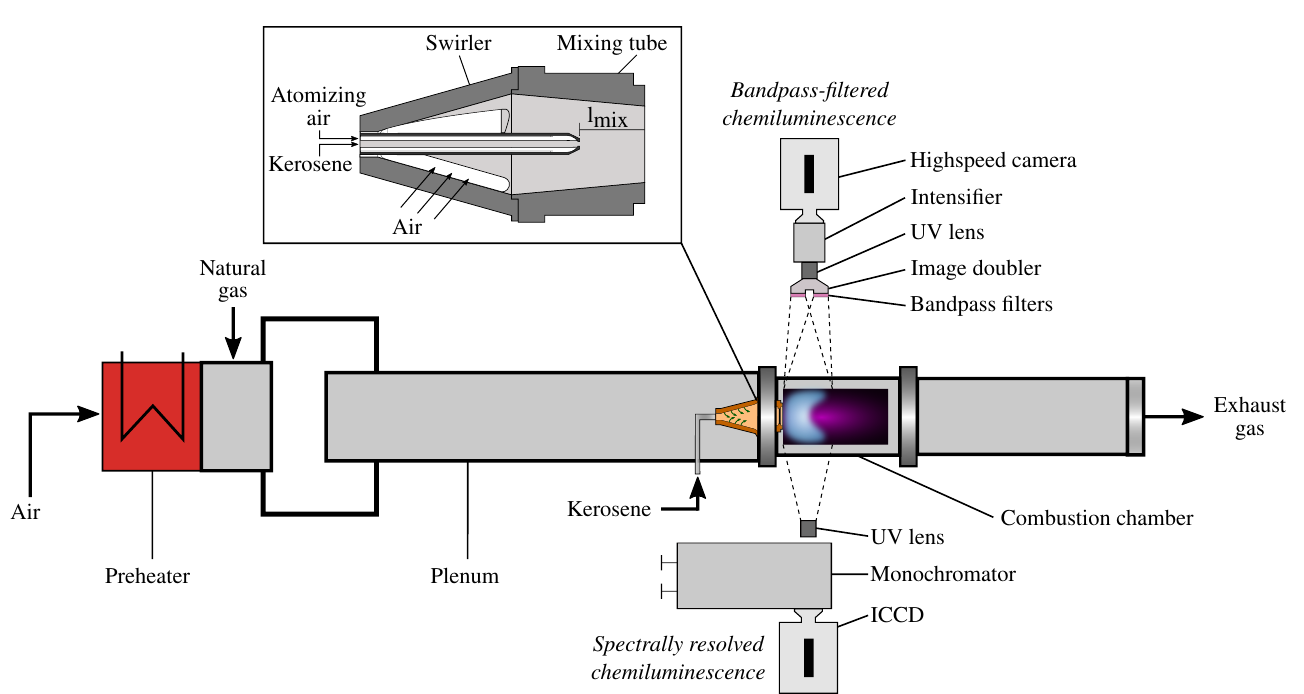
Figure 1. Schematic sketch of the single burner test rig with modular swirl burner system and measurement